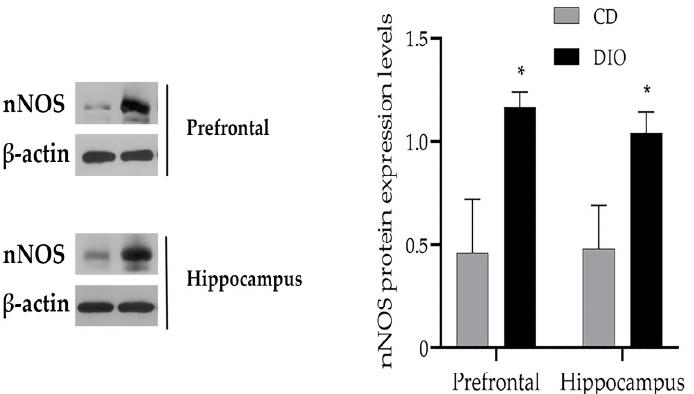
Figure 7. The expression of nNOS in the prefrontal cortex and hippocampus of DIO mice increases significantly. * p < 0.05. When compared with the CD group, the results were presented as the mean ± SD.